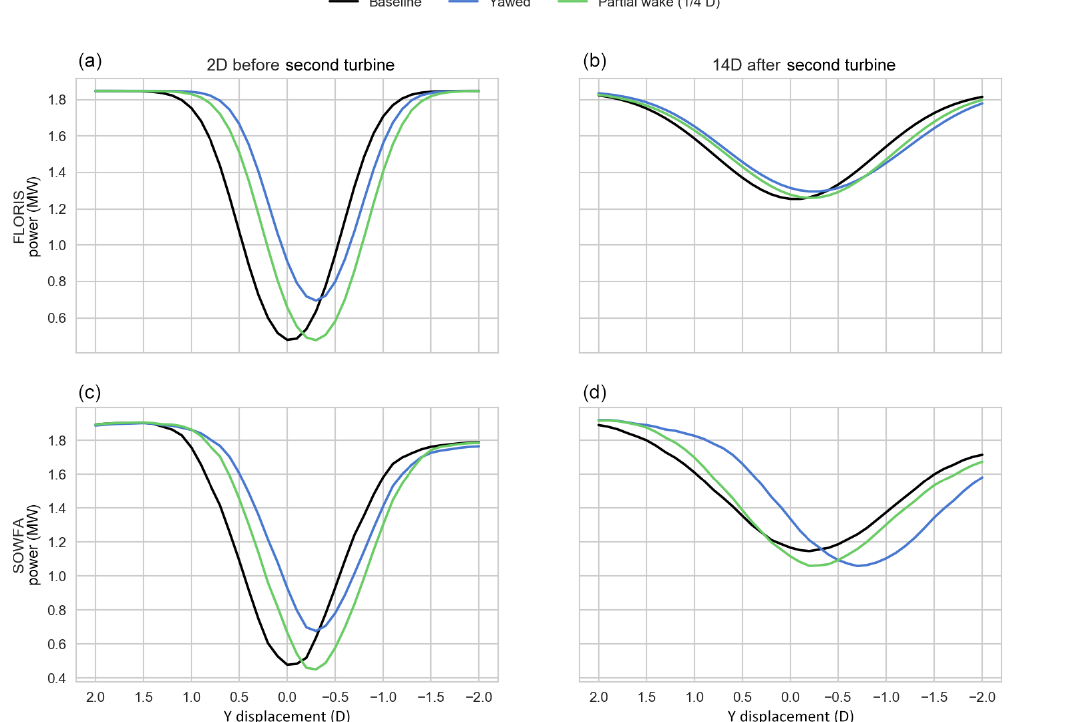
Figure 9. Power of a hypothetical turbine in baseline, yawed ( + 25 ◦ ), and partial wake. Panels (a) and (c) shows the power profile 2 diameters (D) before the second turbine, while panels (b) and (d) is 14D behind.